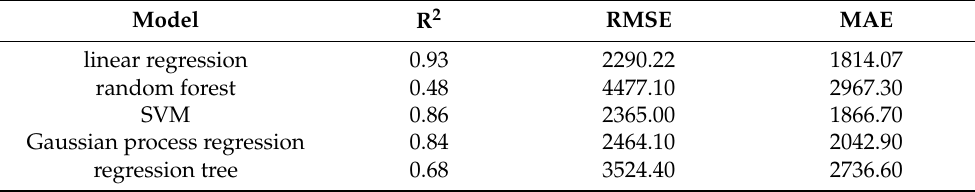
Table 5. The regression accuracy of the GDP model of the tertiary industry. Model R